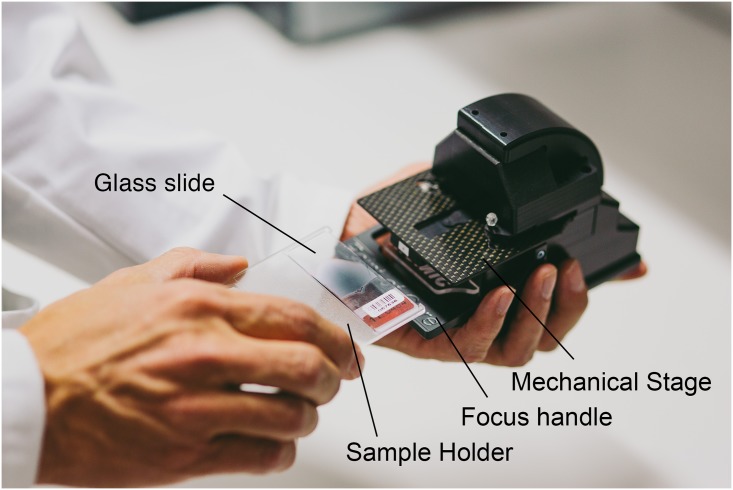
MoMic miniature microscope prototype.The glass slide is placed in the sample holder which is then inserted on the mechanical stage, and used for manual adjustment of the sample position.